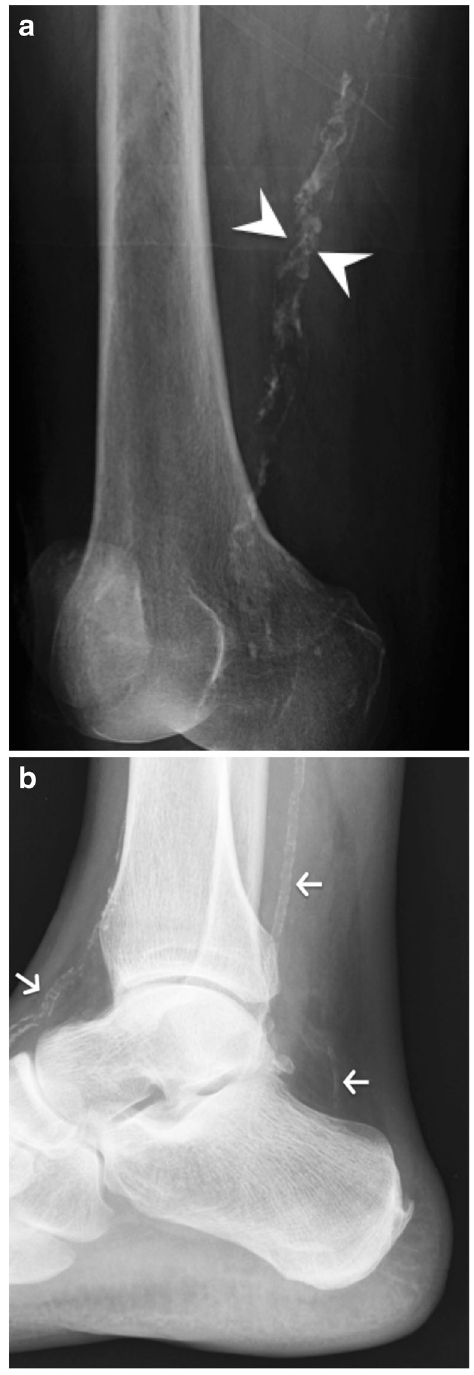
Fig. 21 Vascular calcifications. ( a ) Oblique radiograph of the femur shows atherosclerotic vascular calcifications (arrowheads) and ( b ) lateral radiograph of the ankle shows metabolic vascular calcifications (arrows)